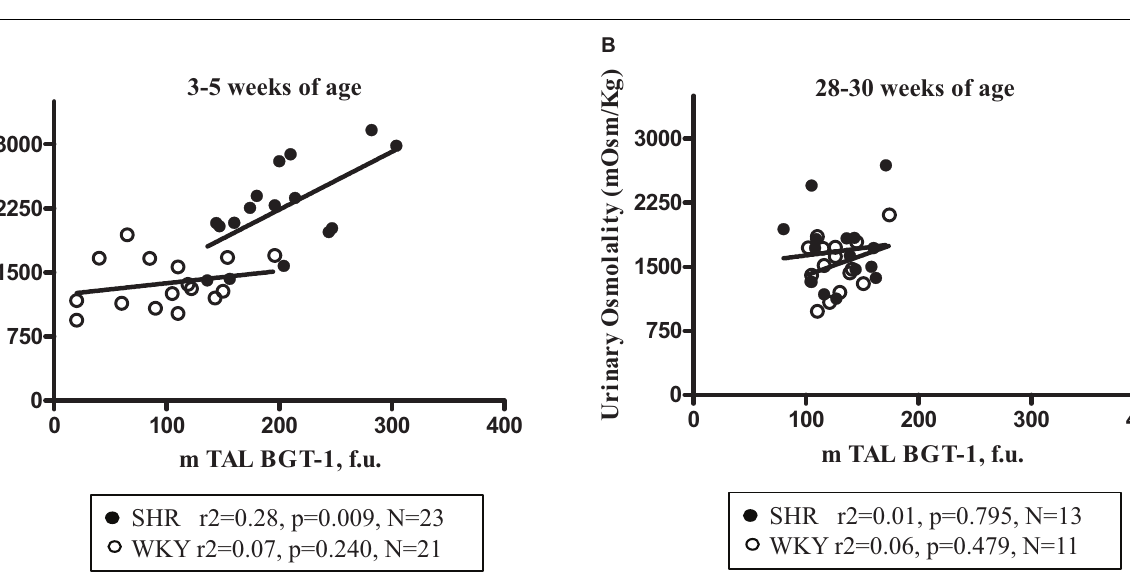
FIGURE 5 | Relationship between urine osmolality and m-TAL BGT-1 expression (medullary thick ascending limbs of Henle’s loop betaine γ -amino-n-butyric acid transporter-1) in young (3–5-week-old) female SHR (filled circles) and age-matched WKY (open circles) (A) and in old (28–30-week-old) SHR (filled circles) and age-matched WKY (open circles) (B)